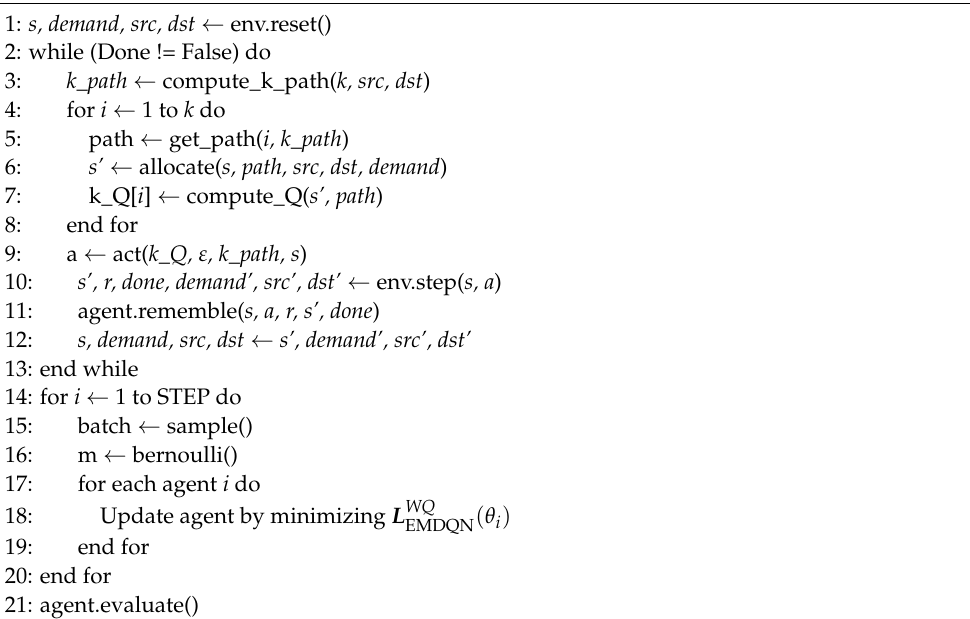
Algorithm 1: working process of the EMDQN